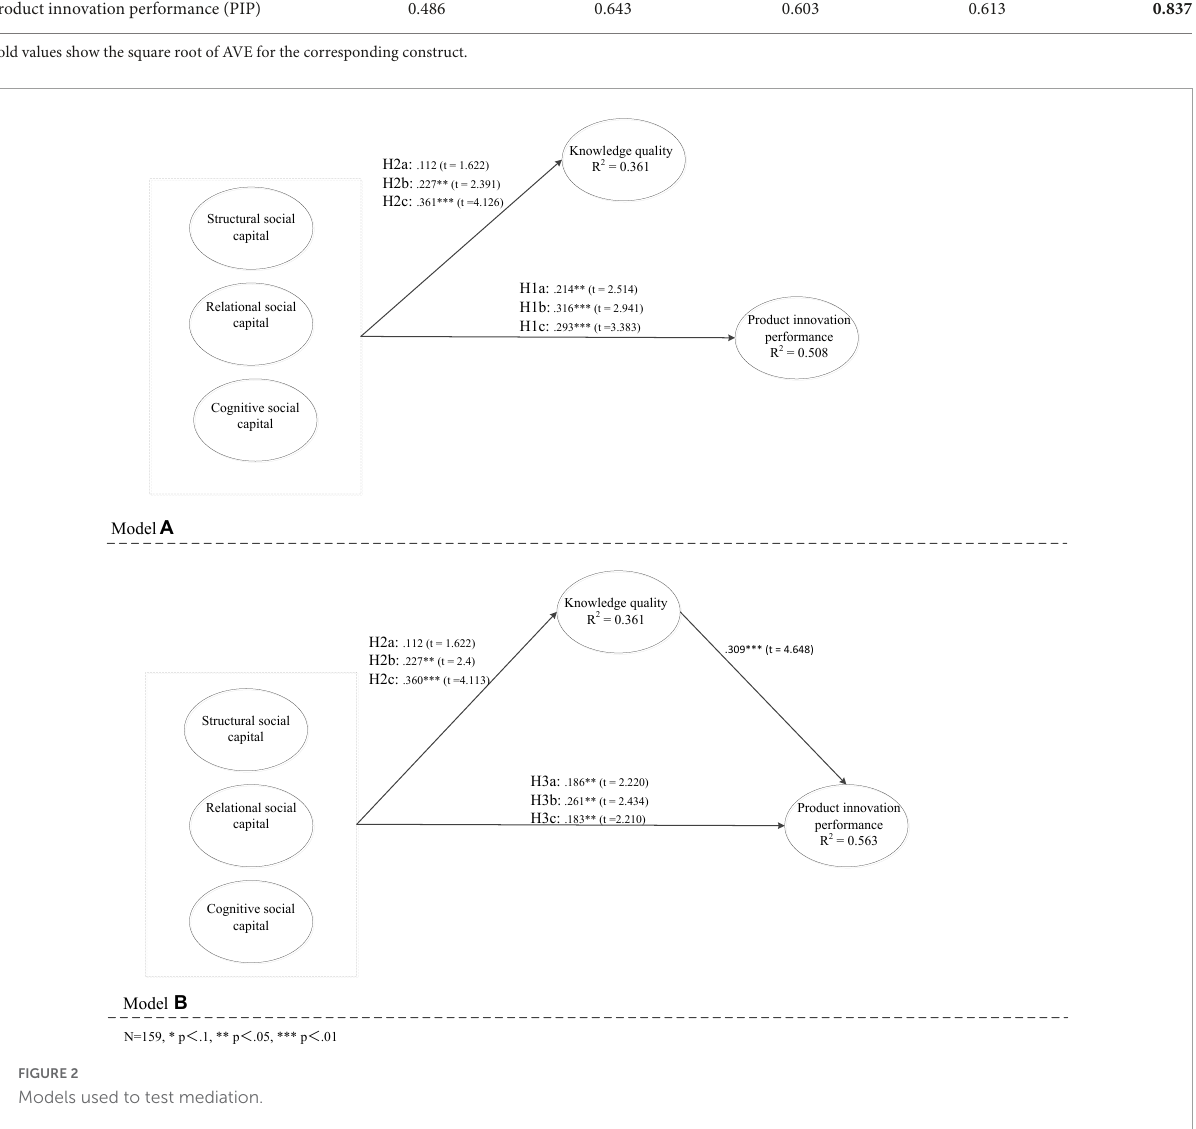
FIGURE2 Models used to test